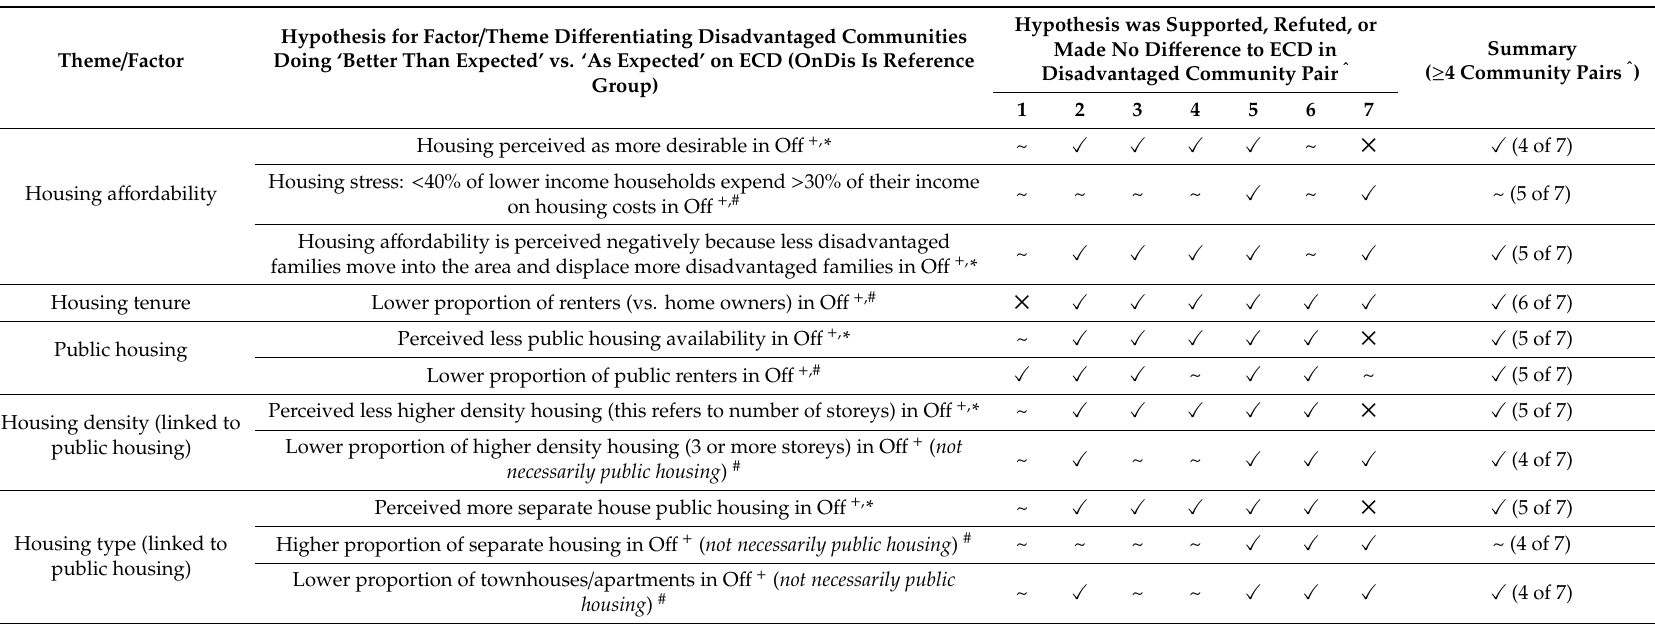
Table 2. Qualitative and quantitative housing findings for the matched-disadvantaged community